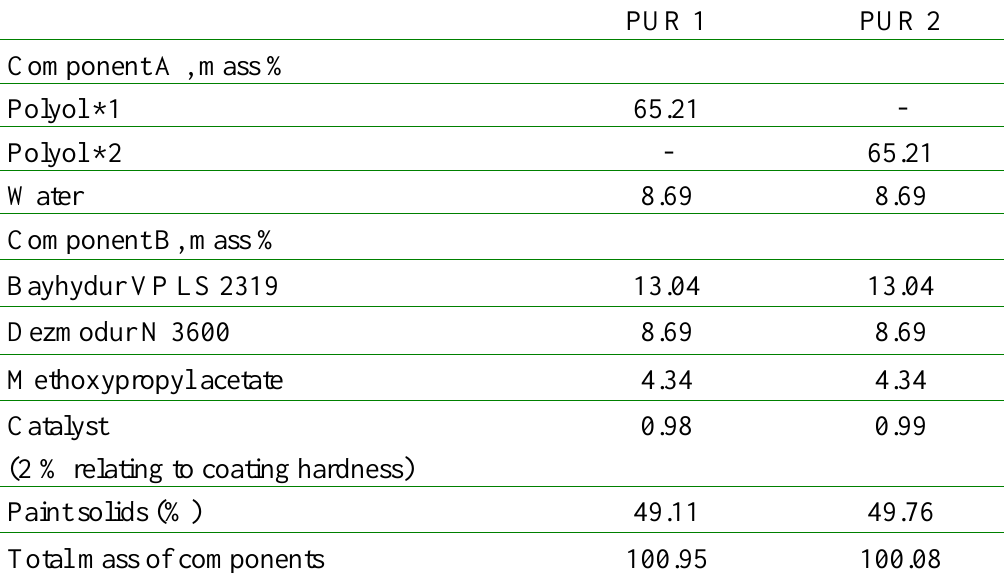
Table 2 . Characteristics of the two-component aqueous polyurethane